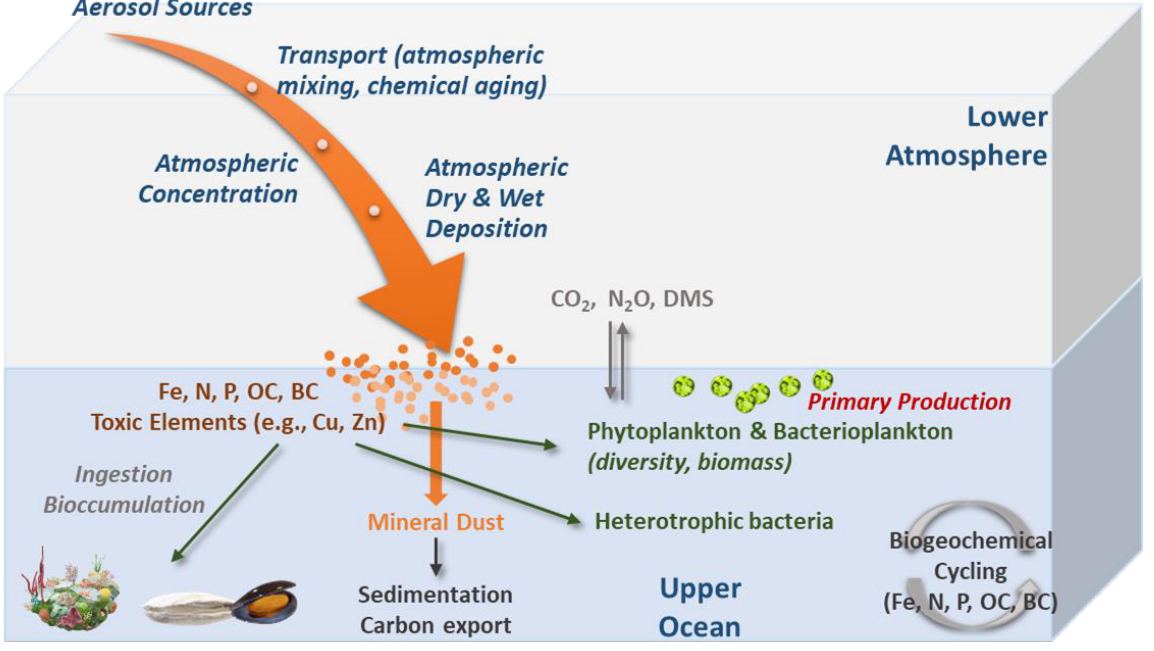
Figure 3. Conceptual diagram illustrating the main processes of atmospheric aerosols (wet and dry) deposition and main changes occurring in the marine biota.